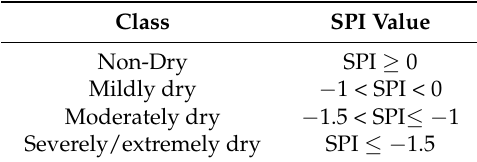
Table 2. The standardized precipitation index (SPI) categories based on the initial classification of SPI